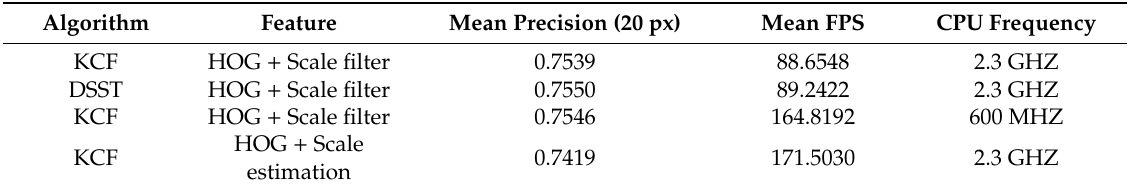
Table 3. Performance comparison.